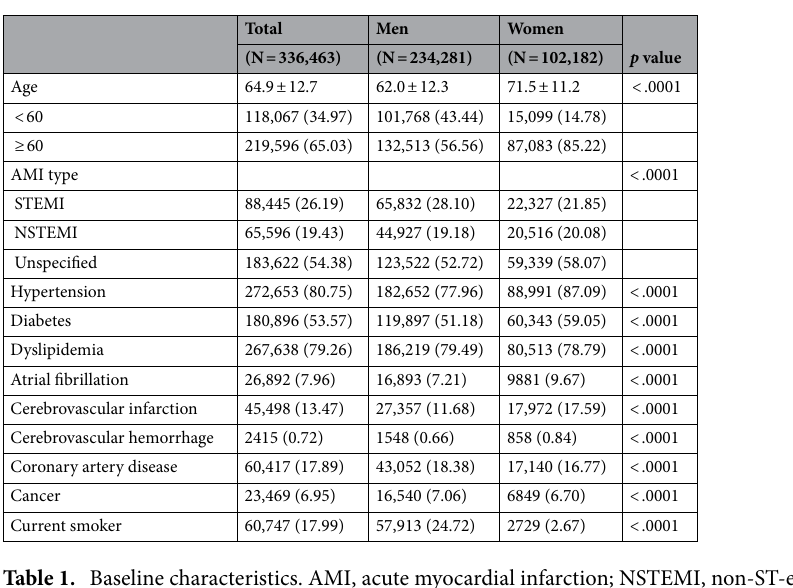
Table 1. Baseline characteristics. AMI, acute myocardial infarction; NSTEMI, non-ST-elevation myocardial infarction; STEMI, ST-elevation myocardial